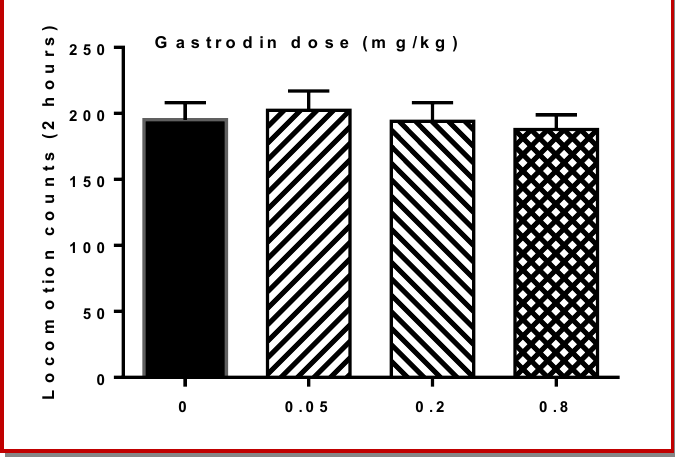
Figure 5: Effect of gastrodin on general locomotor activity in mice (n = 8 per